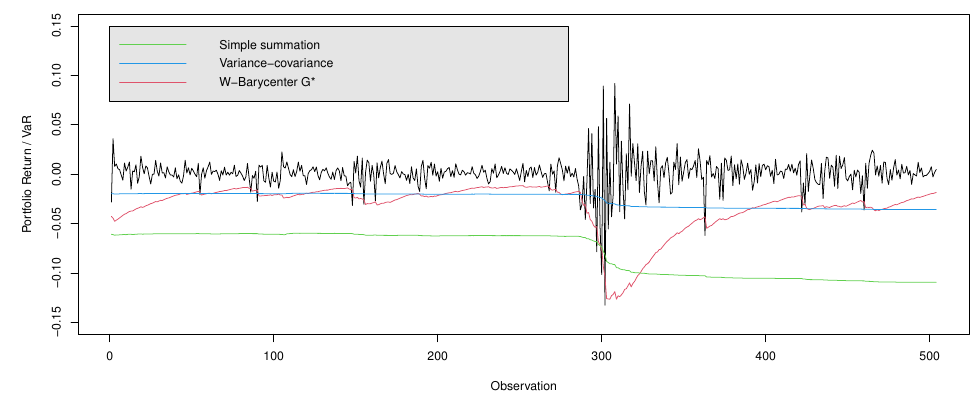
Figure 1. Daily Return series and VaR during the COVID-19 pandemic.